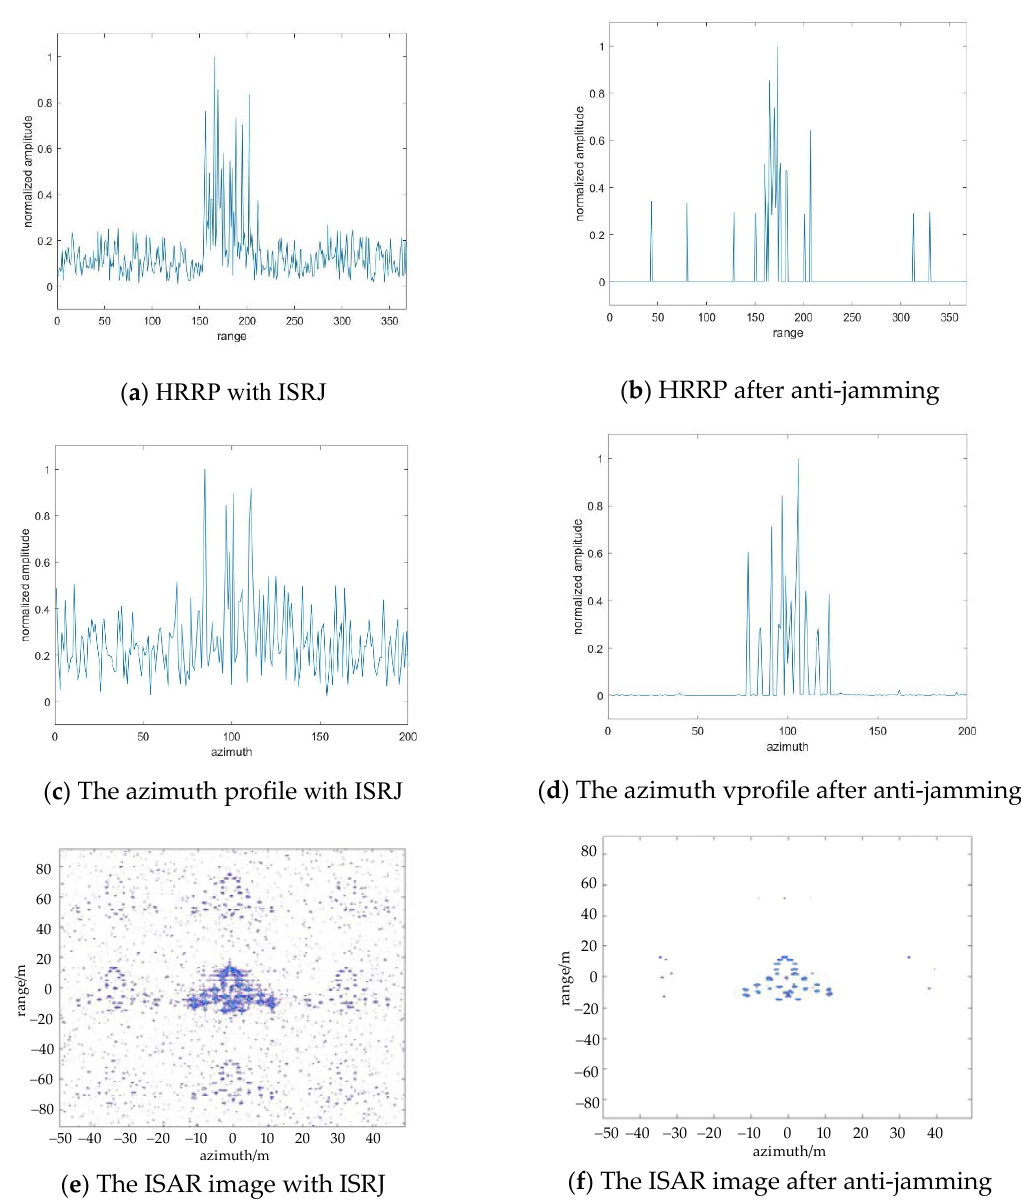
( f ) The ISAR image after anti ‐ jamming Figure 10. The results of ISRJ jamming and anti-jamming in the fast and slow time domain with Figure 10. The results of ISRJ jamming and anti ‐ jamming in the fast and slow time domain with JSR = 0dB and SNR = −  JSR 0dB and  SNR ‐ 5dB .